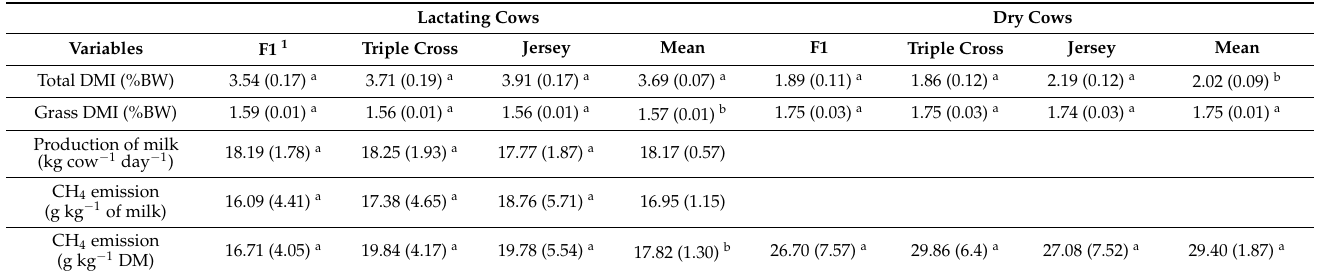
Table 5. Feed consumption, milk production and CH 4 emissions in lactating and dry cows of different breed groups (mean + sd).